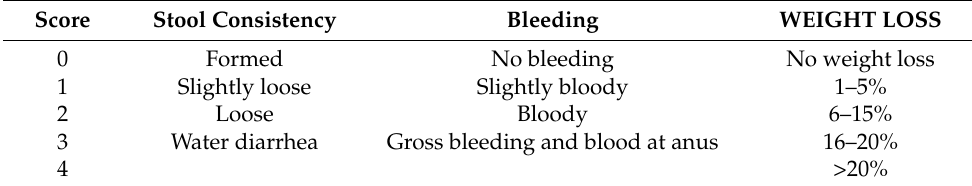
Table 1. Disease activity index (DAI) score parameters.